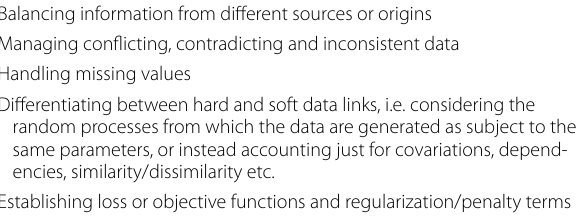
Table 4 Data fusion critical aspects Balancing information from different sources or origins Managing conflicting, contradicting and inconsistent data Handling missing